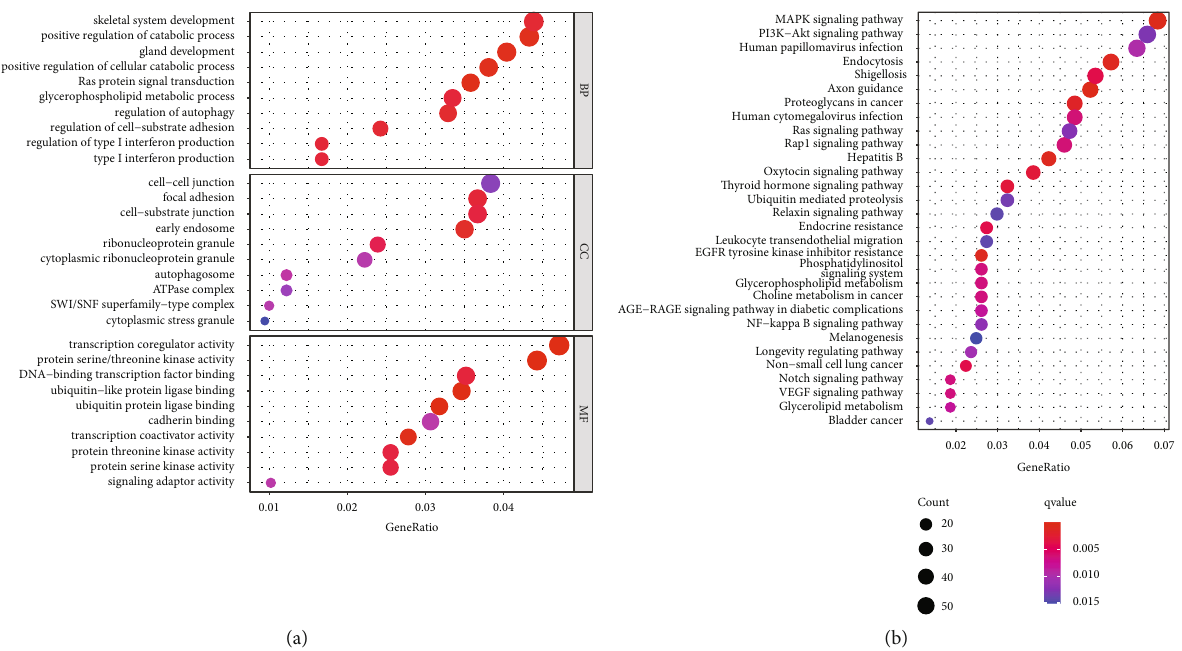
Figure 5: Functional analysis based on the targeting genes of hsa-miR-3918. (a) GO enrichment was shown on a bubble graph. (b) KEGG assay was shown on a bubble